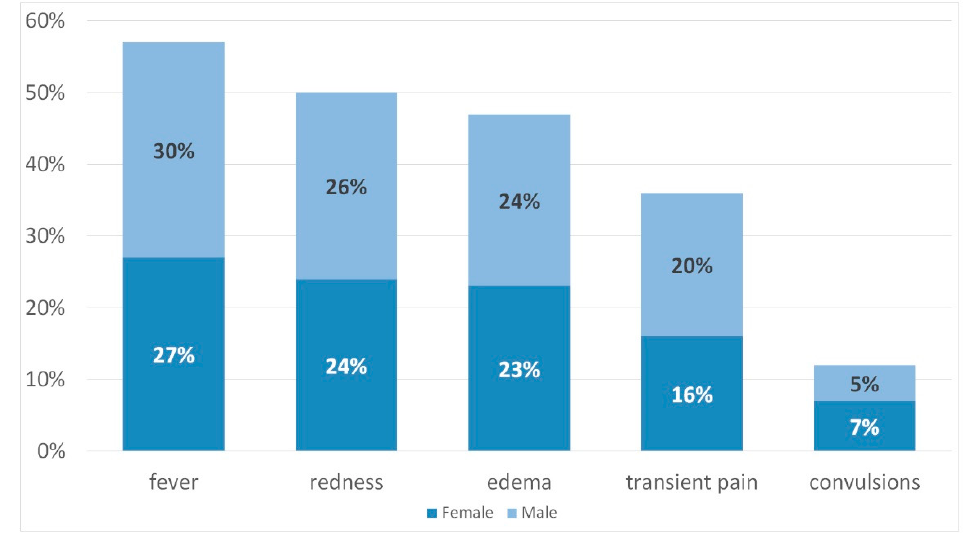
Figure 3. Parents’ knowledge of possible vaccination reactions.